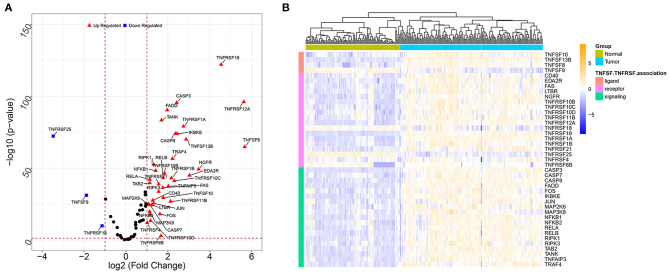
The volcano plots and heat map for DEGs between the tumor sample and normal sample. (A) The volcano plots of DEGs; the X-axis represents the value of log2 fold change, while the Y-axis represents the value of –log10; red triangles represent the upregulated genes, blue squares represent the downregulated genes, and black nodes represent genes with no significant difference. (B) The heat map for DEGs; colors from blue to yellow indicated low to high representation values. The colored blocks at the top represent samples, of which brilliant blue represents tumor samples and pea green represents normal samples; the colored blocks at the left represent DEGs.